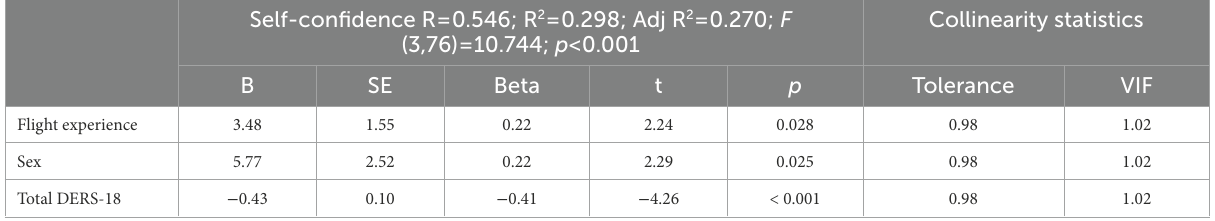
TABLE 3A Multiple regression model performed on self-confidence with flight experience, sex, and the emotional dysregulation’s totale score (Total DERS-18) as indipendent variables.